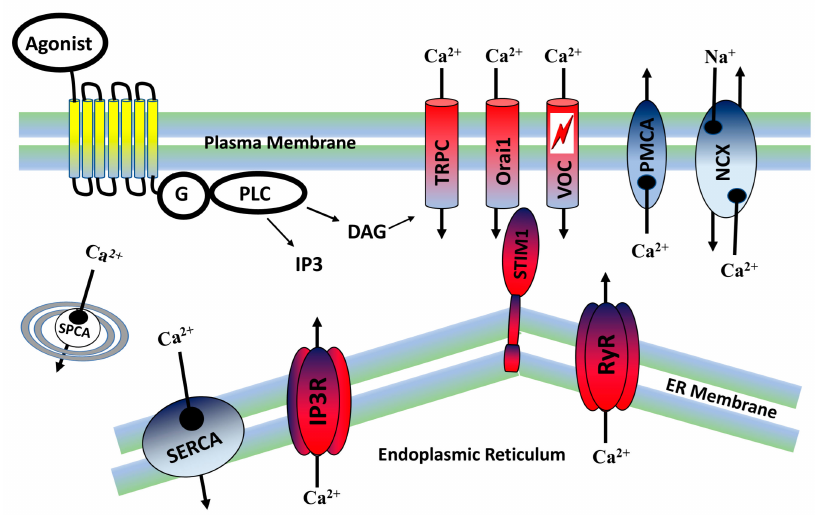
Figure 1. Mechanisms of Ca 2 + signaling. Upon activation of a G-protein coupled receptor (GPCR) by an agonist, phospholipase C (PLC) is activated, which generates two second messengers; diacylglycerol (DAG) and inositol 1,4,5-triphosphate (IP3). DAG is capable of activating TRPC channels in the